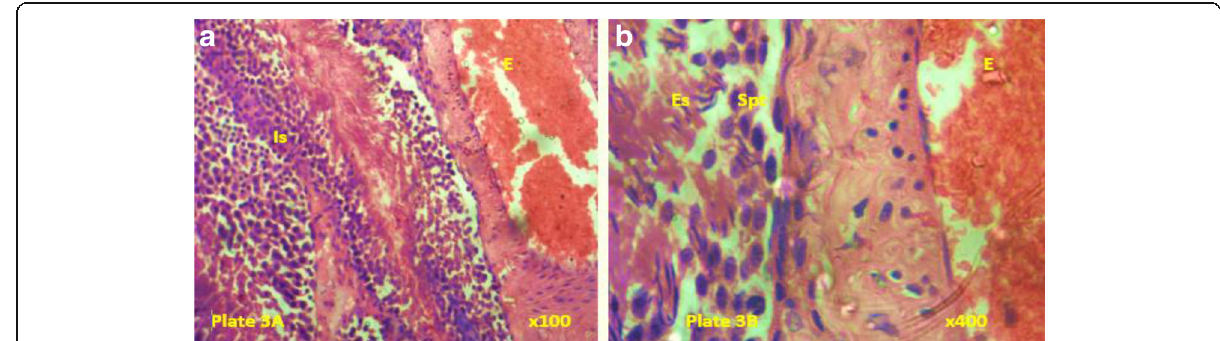
Fig. 7 a , b Photomicrograph of testes of group 1: Representative testicular micrograph of Wistar rats given 100mg/kg/d of aluminum chloride and 1ml of pineapple juice (PJ) showing mild degenerative changes of seminiferous tubules; Testicular necrosis (E). Spt spermatogonia, Es elongated spermatids, Rs Round spermatids, It Interstitial space, Spz spermatozoa. Stain is H&E and Magnification x 100 and x 400